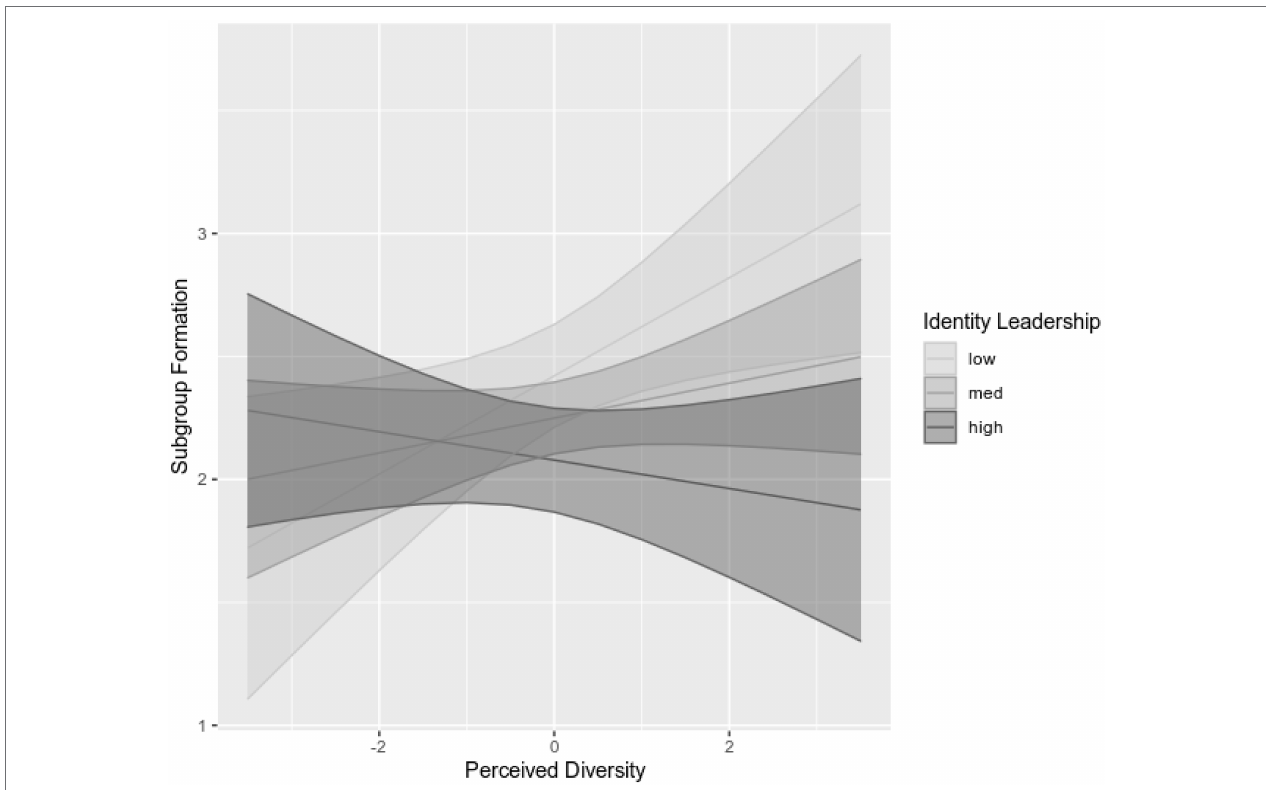
FIGURE 3 | The relationship between perceived diversity and subgroup formation at low, medium, and high levels of identity leadership. 95%-confidence intervals are depicted around the